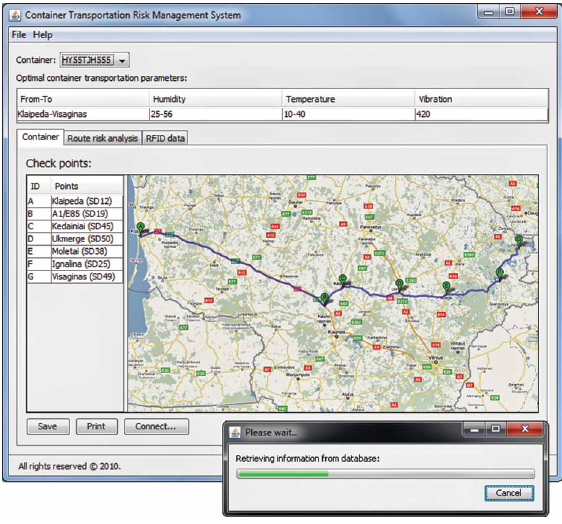
Fig. 8 . Initial route description and the main parameters update function (initial database with all the statistical